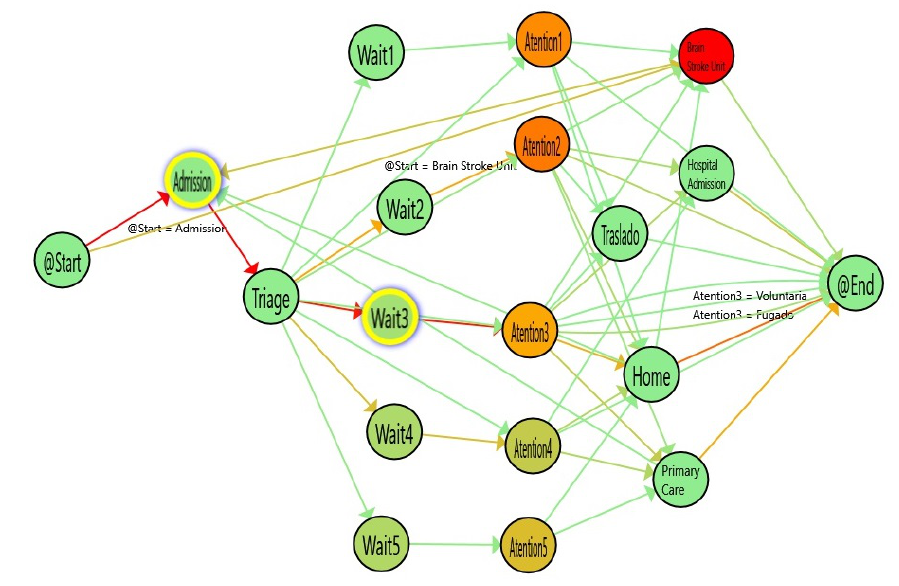
Figure 9. Flow for double triage (from March to June 2017). The colors in nodes represent the average time spent on each activity and the colors of the edges represent the number of patients that followed this